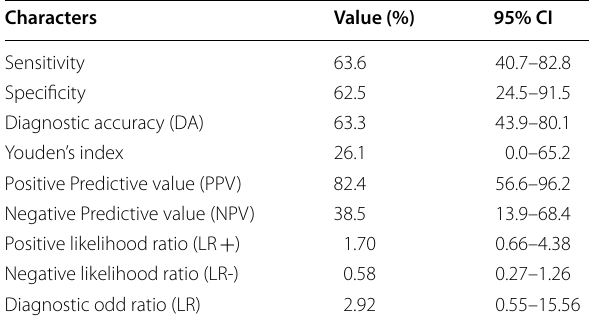
Table 9 Diagnostic characteristics of MRI MRS findings (non-